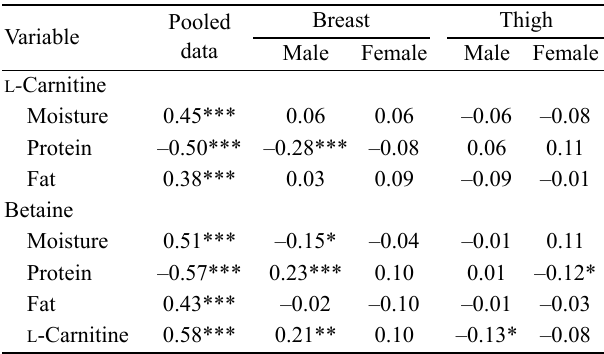
Table 4. Correlation coefficient for L -carnitine and betaine content (mg/100 g) of breast and thigh meat with proximate composition (%)